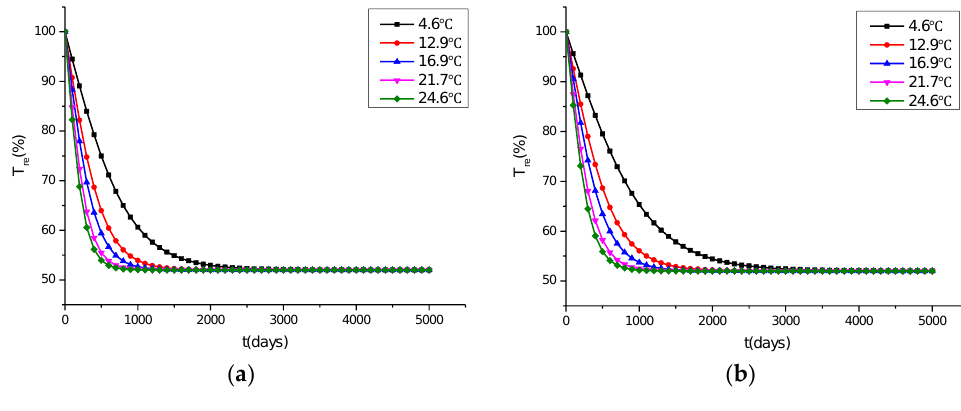
Figure 27. 𝑇 𝑟𝑒 − 𝑡 curves: ( a ) G1; ( b ) G2. Figure 27. T re − t curves: ( a ) G1; ( b )